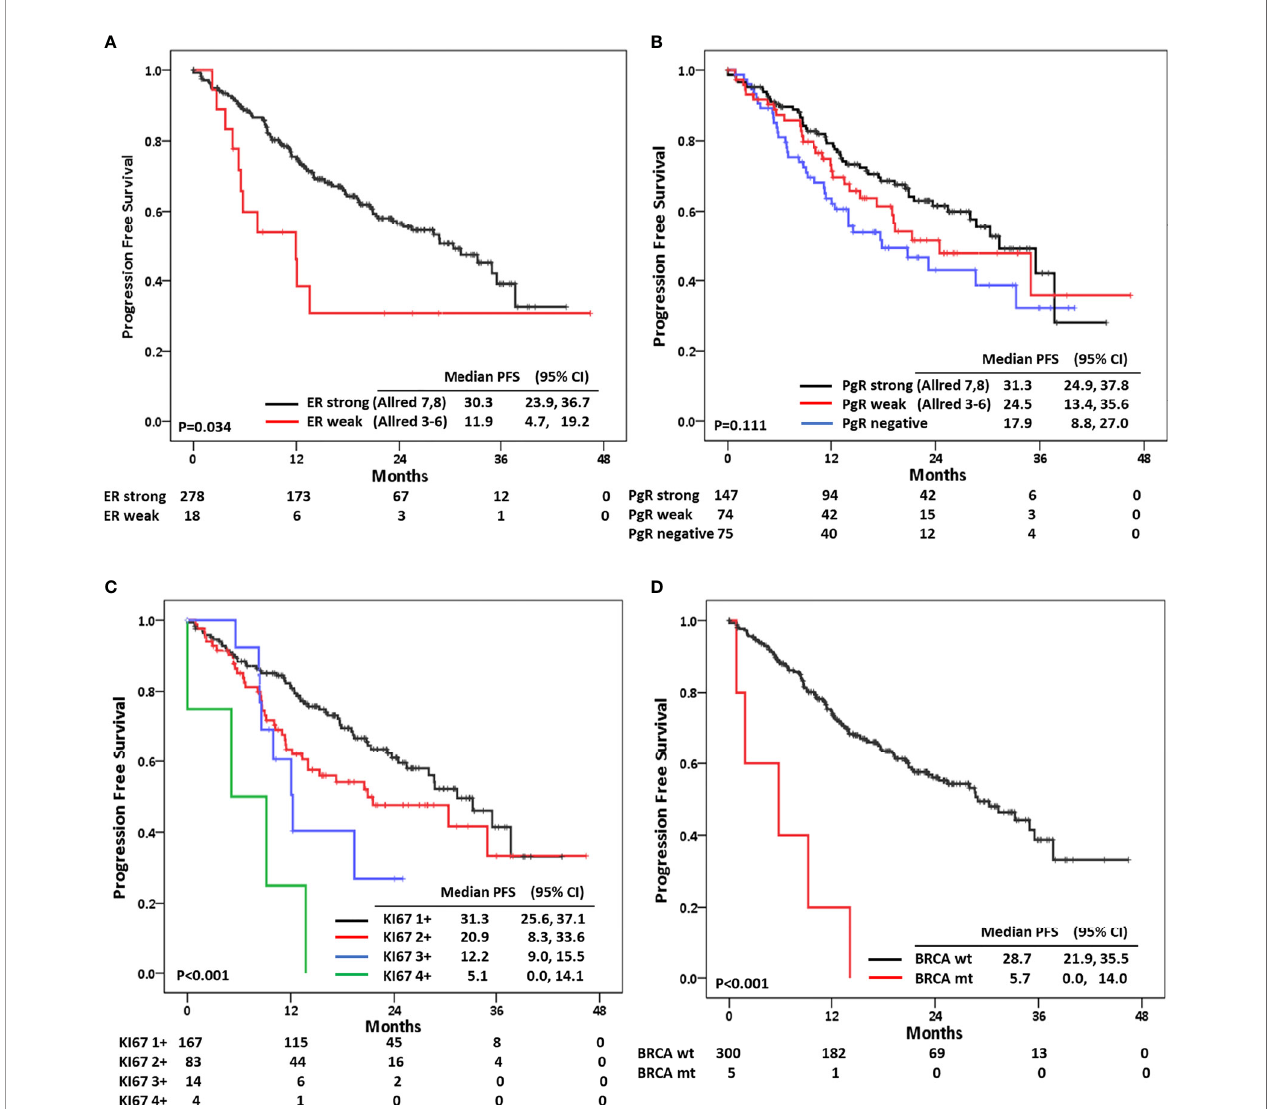
FIGURE 2 | Progression-free survival according to (A) estrogen receptor status, (B) progesterone receptor status, (C) Ki-67 expression status, and (D) germline BRCA